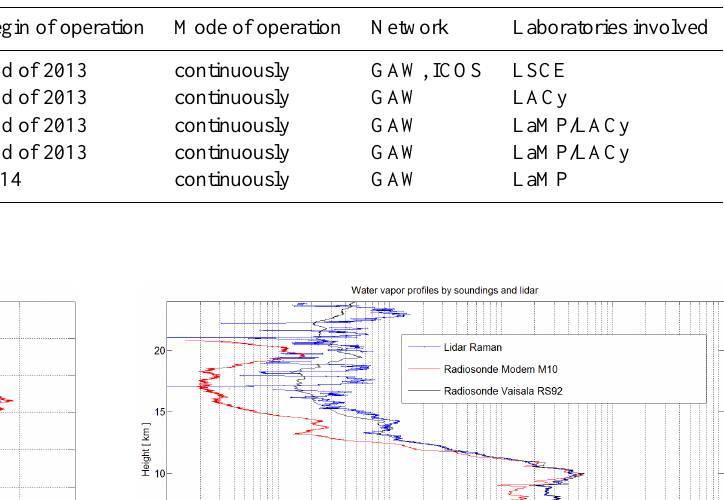
Table 2. List of instruments planned to be deployed at the Maïdo observatory.